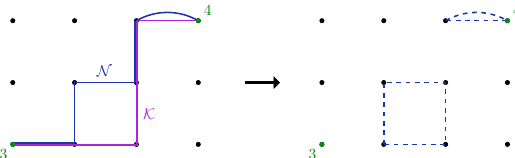
Figure 6: For the graph (cid:77) from the previous figure, we show two subgraphs (cid:78) , (cid:75) with ∂ (cid:78) = ∂ (cid:75) = { 3,4 } (left) and their symmetric difference (cid:78) (cid:48) = (cid:78) (cid:52)(cid:75) which has ∂ (cid:78) (cid:48) = ∅ (right, dashed